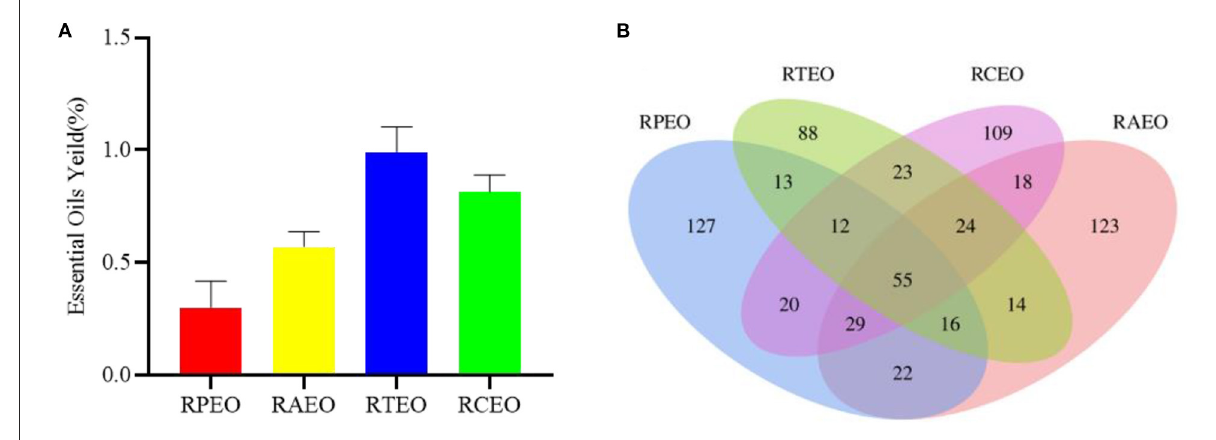
FIGURE1 The yields of four essential oils (A) and venn picture of common compositions of four essential oils (B) .